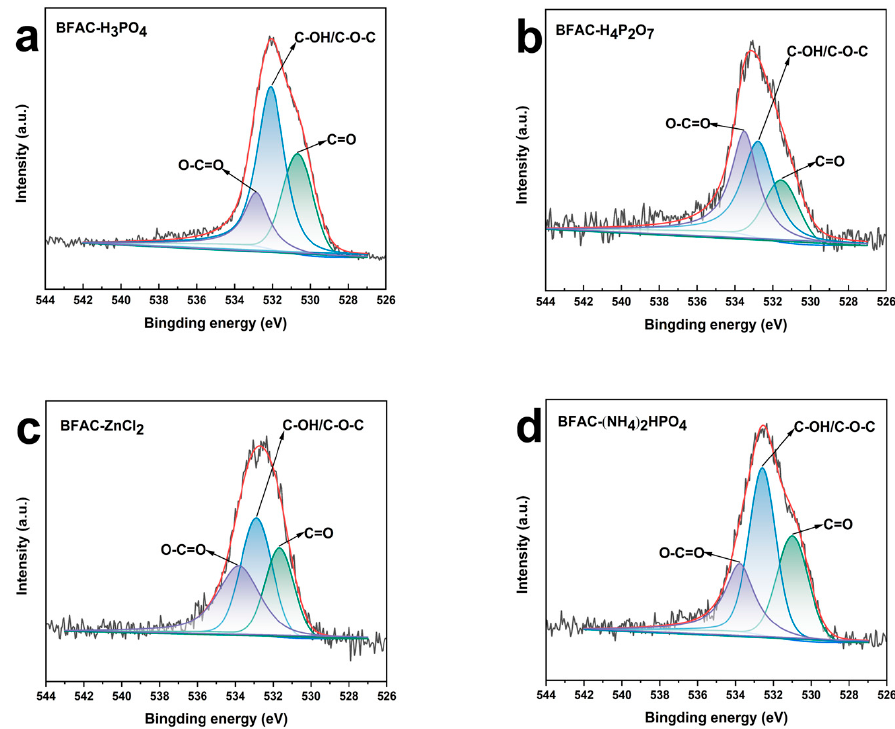
Figure 8. O1s spectra of BFACs activated by different activators ( a ) BFAC-H 3 PO 4 , ( b ) BFAC-H 4 P 2 O 7 , ( c ) BFAC-ZnCl 2 , ( d ) (NH 4 ) 2 HPO 4 .